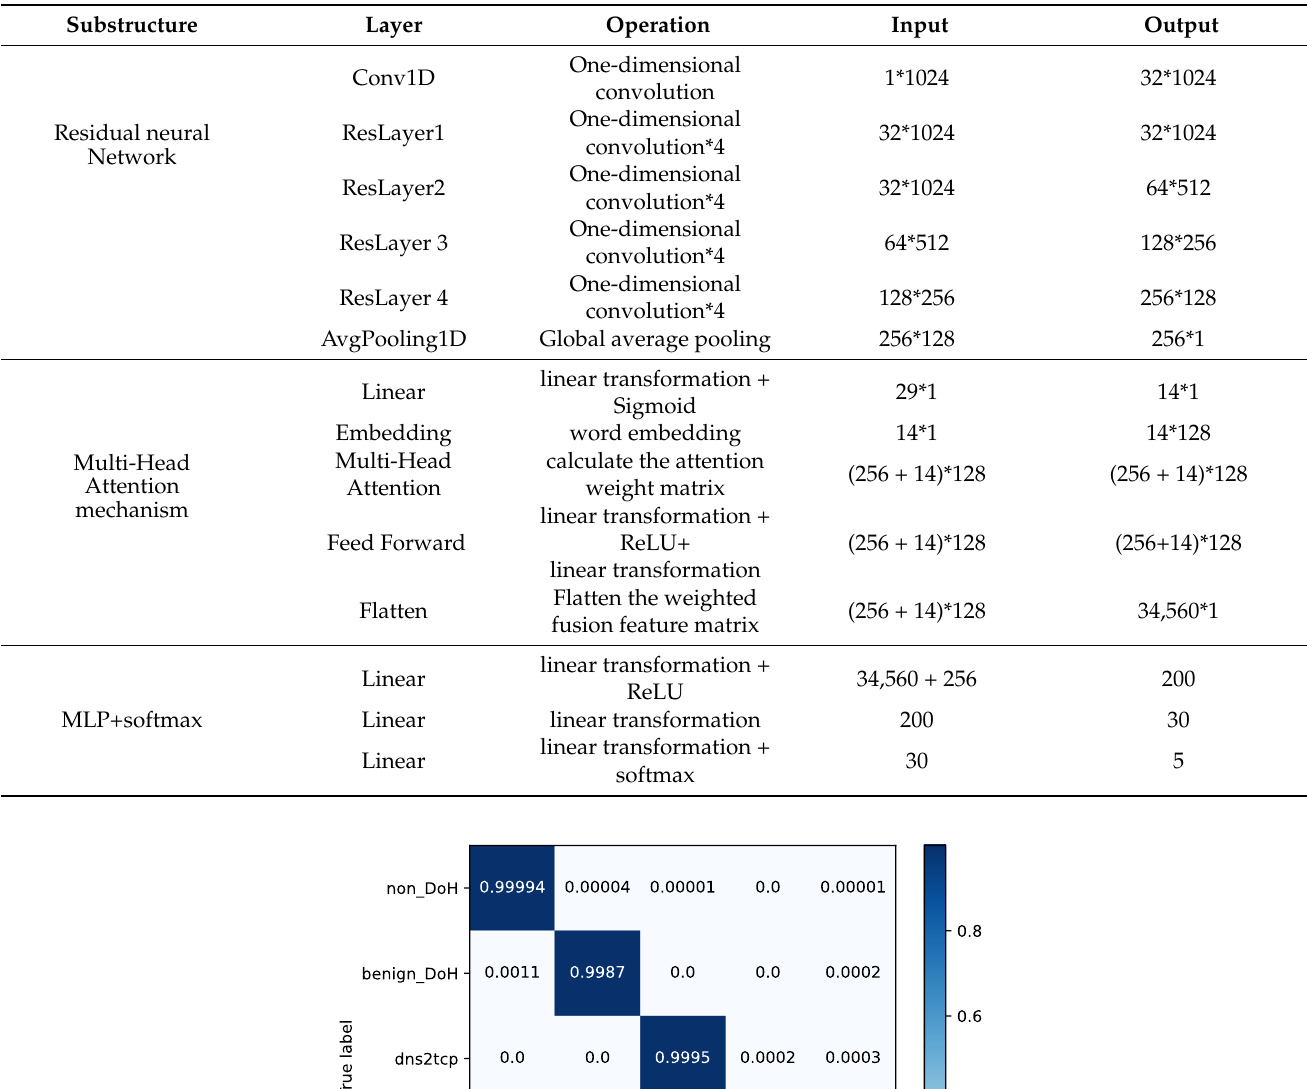
Table 4. Structural parameters in MHA-Resnet.